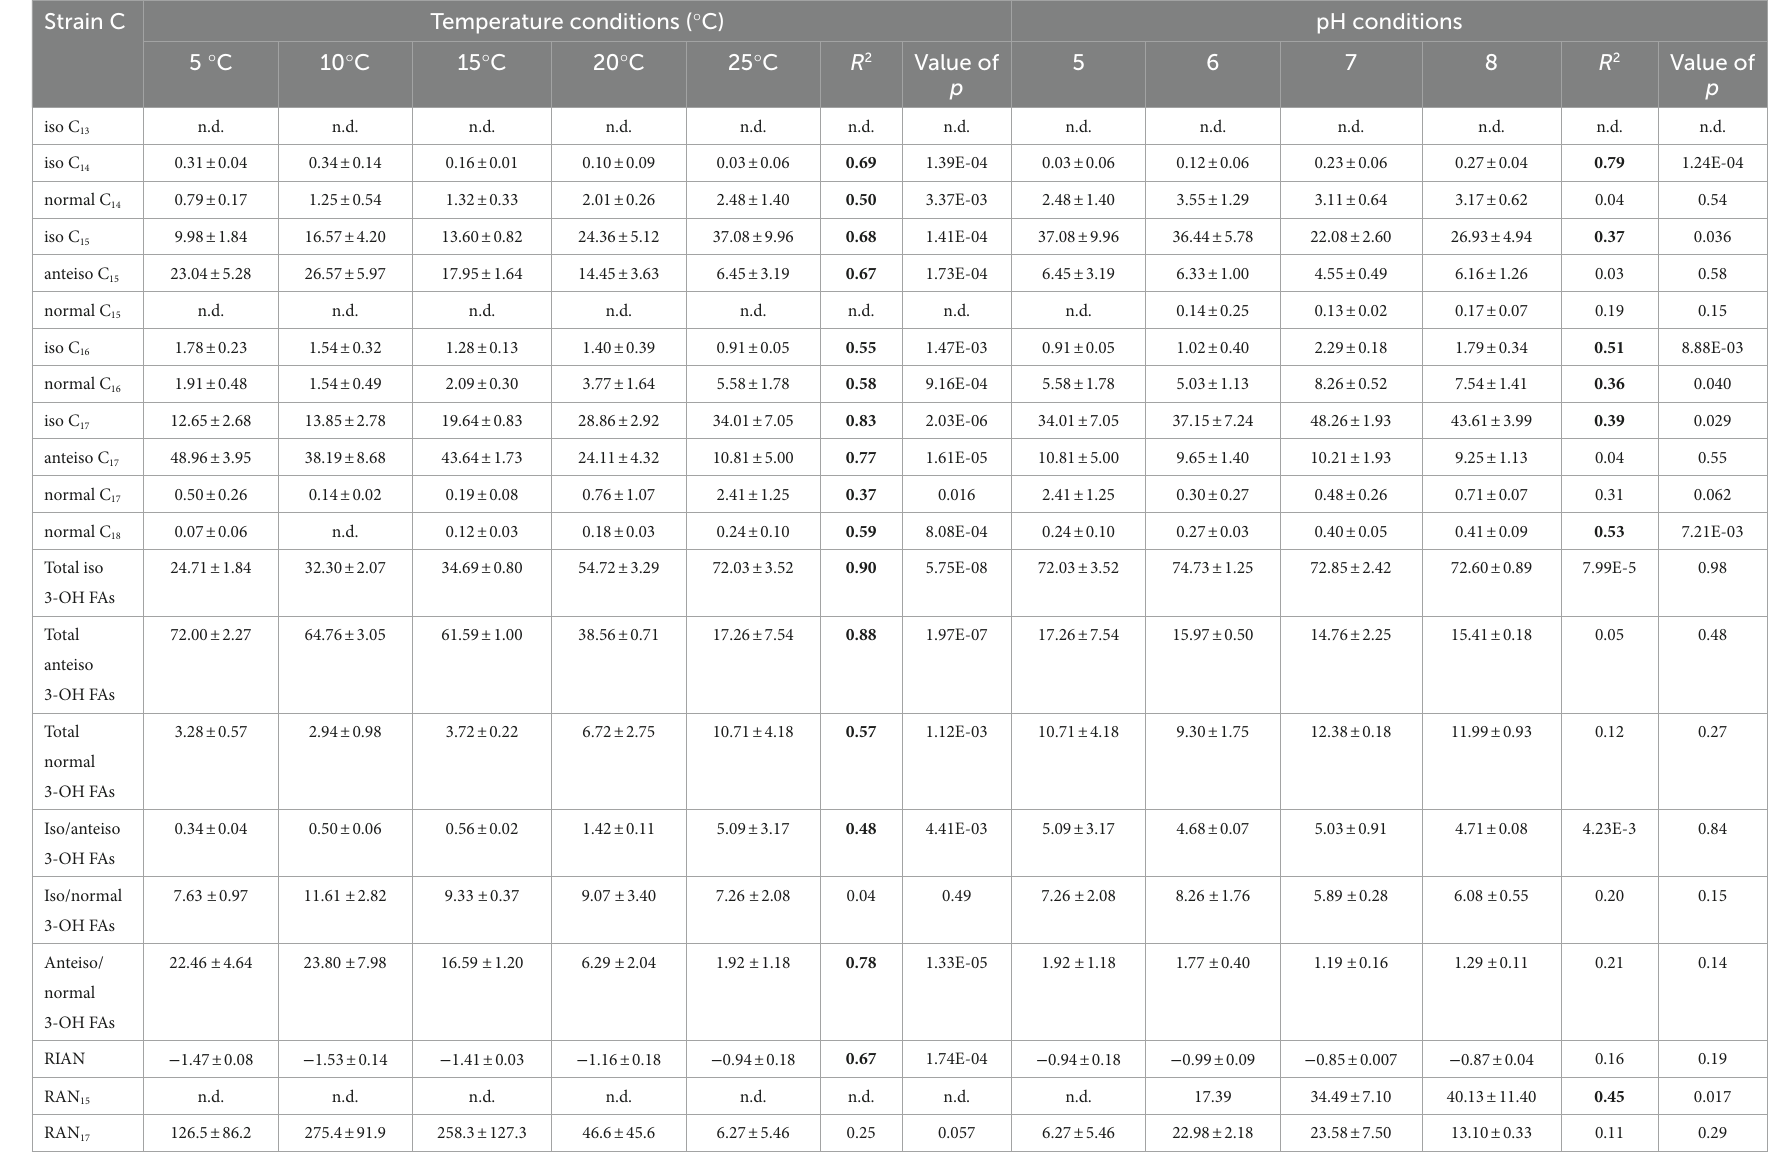
TABLE 6 Relative percentage abundances of 3-hydroxy fatty acids vs. total 3-hydroxy fatty acids and related indices [defined by Wang et al. (2016)] for strain C cultivated under different temperature (at pH 5) and pH (at 25 ° C)